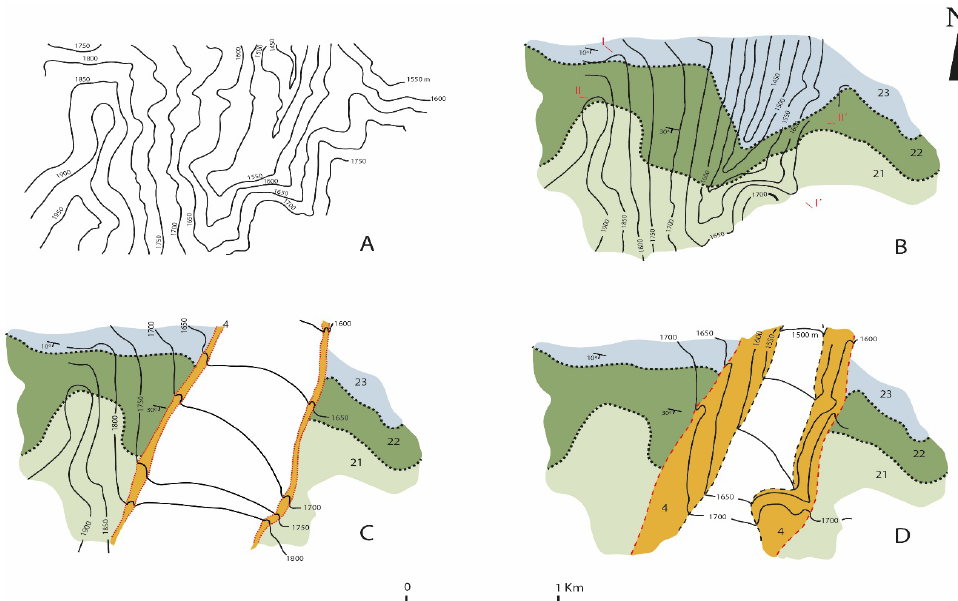
Figure 4. Process followed in the reconstruction of the relief before the landslide (see explanation in text): ( A ) Current topography in the area of the slope; ( B ). Reconstruction of the topographic and geology of the slope during the maximum advance of the glacier and under the ice of the glacier tongue and without moraines. (21) Sandstones and lutites (22) Lutites and clays (23) limestone; ( C ). Topographic map in the situation of the maximum advance of the glacier and with a thickness of the glacial tongue of 140 m; ( D ). Topographic map in the situation of regression of the glacier and with a thickness of the glacier tongue of about 40 m.